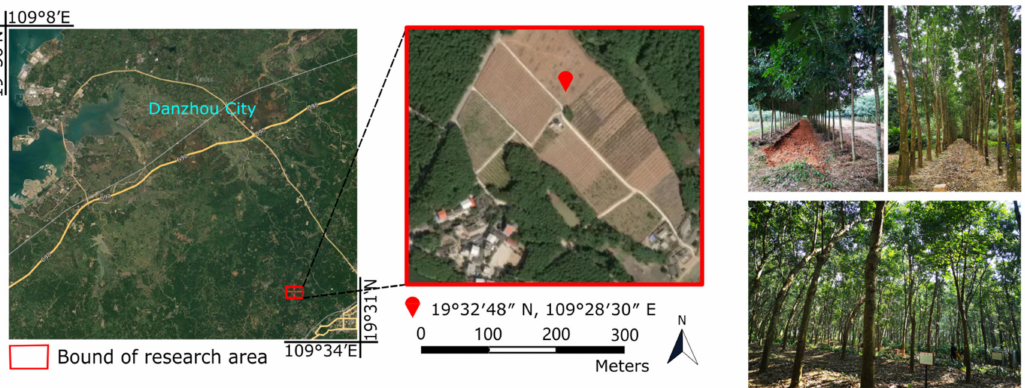
Figure 2. Location of the study area, Danzhou, Hainan Island, China. The left and middle images are remote sensing images from Google Earth, and the right image shows the rubber tree planation in the experimental